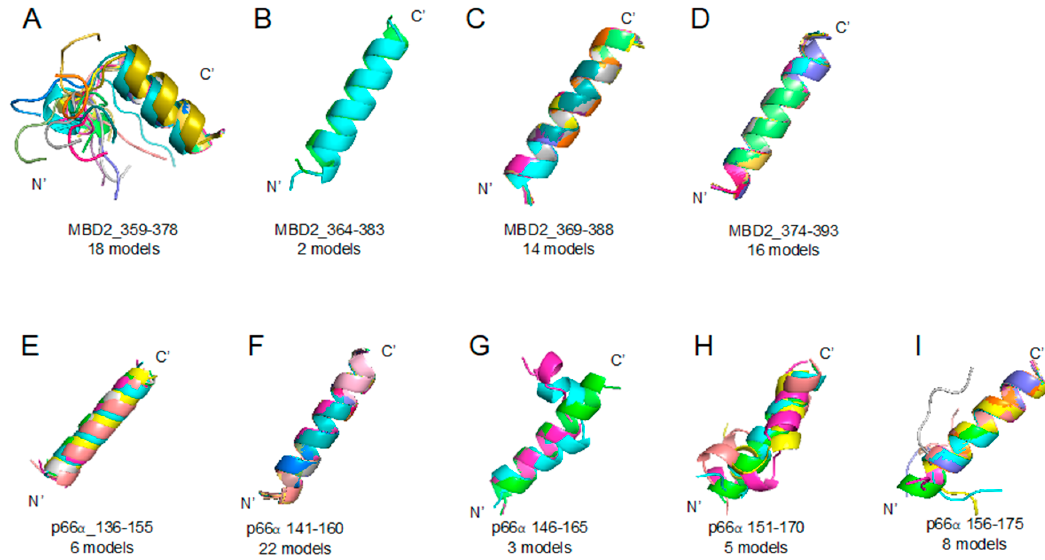
Figure 5. Methyl-CpG-binding domain protein 2 (MBD2) 359–393 region ( A – D ) and p66 α 136–175 region ( E – I ) segmented peptides: PEPFOLD ver 3.5 prediction result of peptide structures based on corresponding sequences (please look at the Table 1). (A) MBD2_359–378 (18 models), (B) MBD2_364–